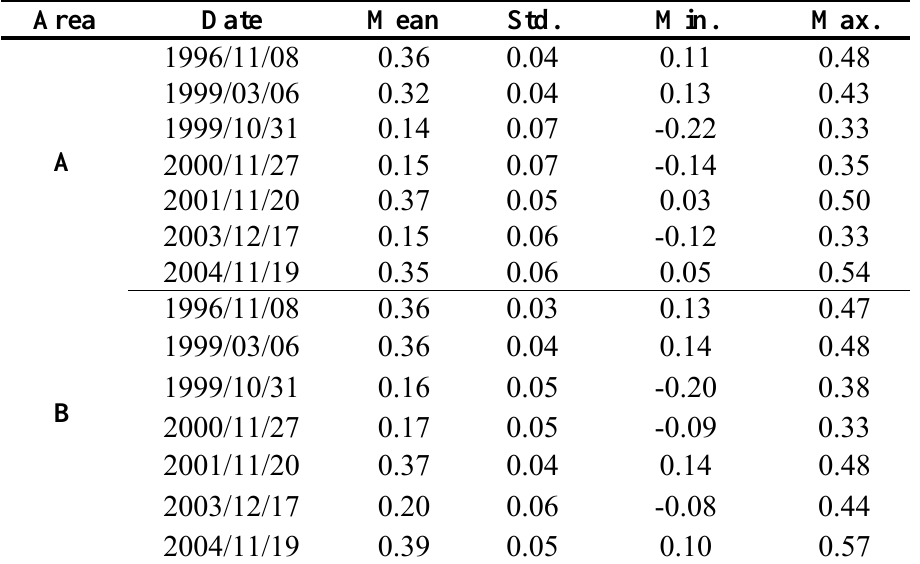
Table 1 Statistics of NDVI